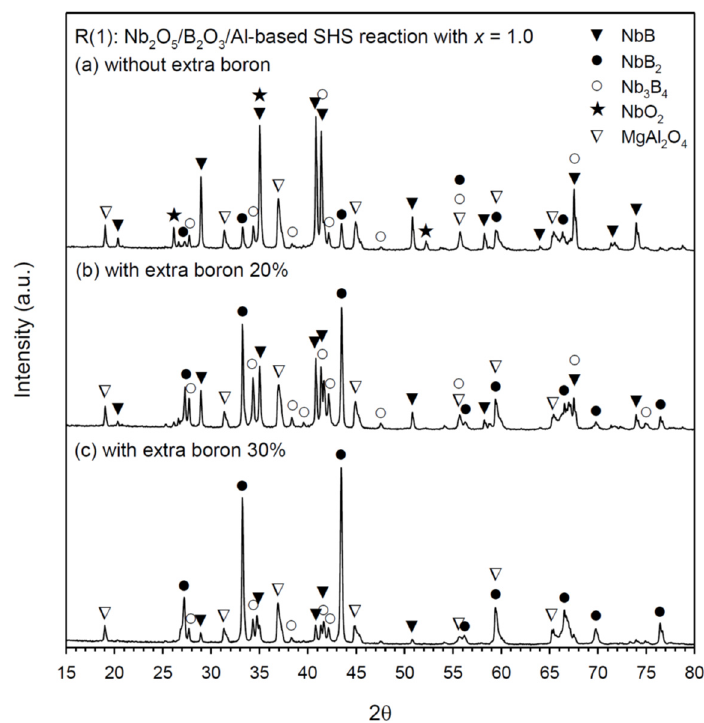
Figure 6. XRD patterns of NbB 2 –MgAl 2 O 4 composites synthesized from Reaction (1) of x = 1.0 under conditions: ( a ) without extra boron, ( b ) with extra boron 20%, and ( c ) with extra boron 30%.